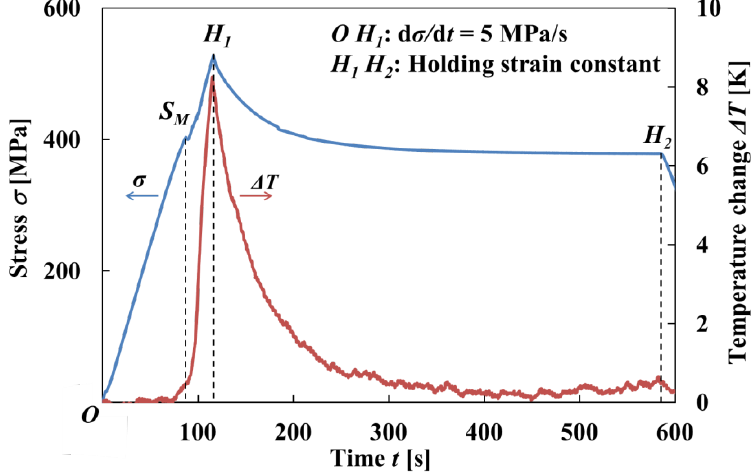
(ε = 6%) and 1 1 to point H . 1 2